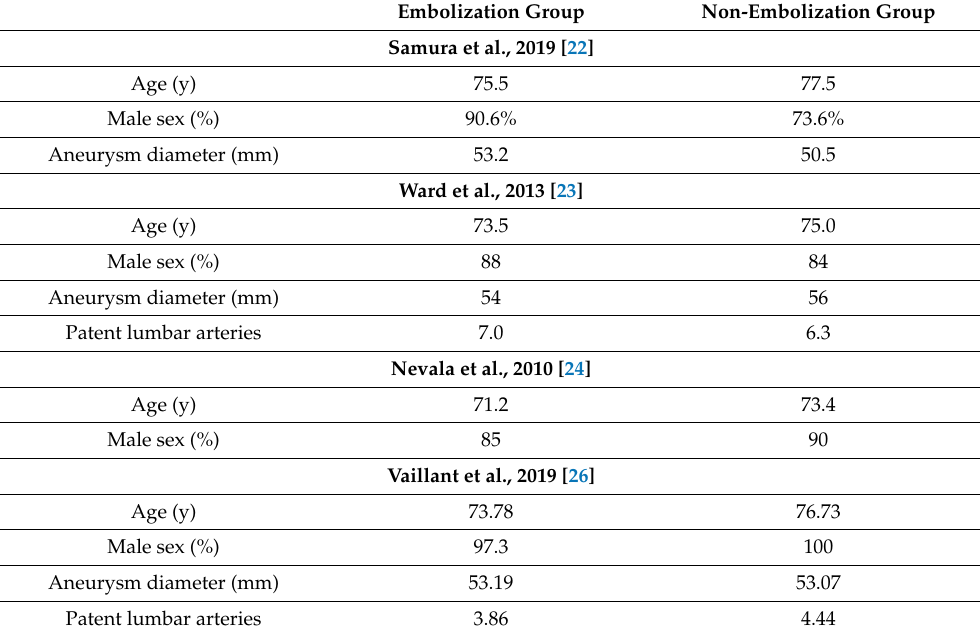
Table 4. Patients’ characteristics.